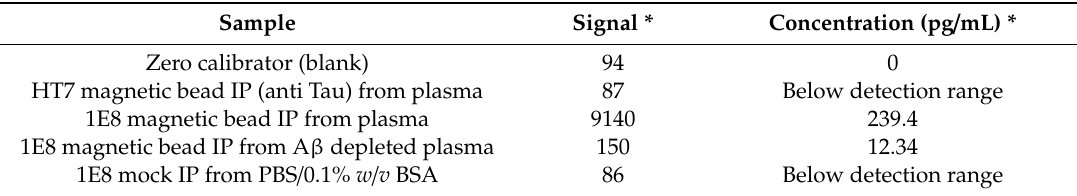
Table 3. Specificity of the two-step